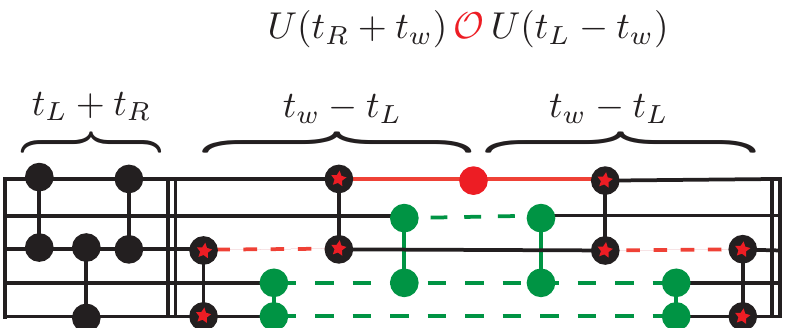
Figure 26. Illustration of the spread of infected qubits in the epidemic model when t and t w t L > (cid:0)